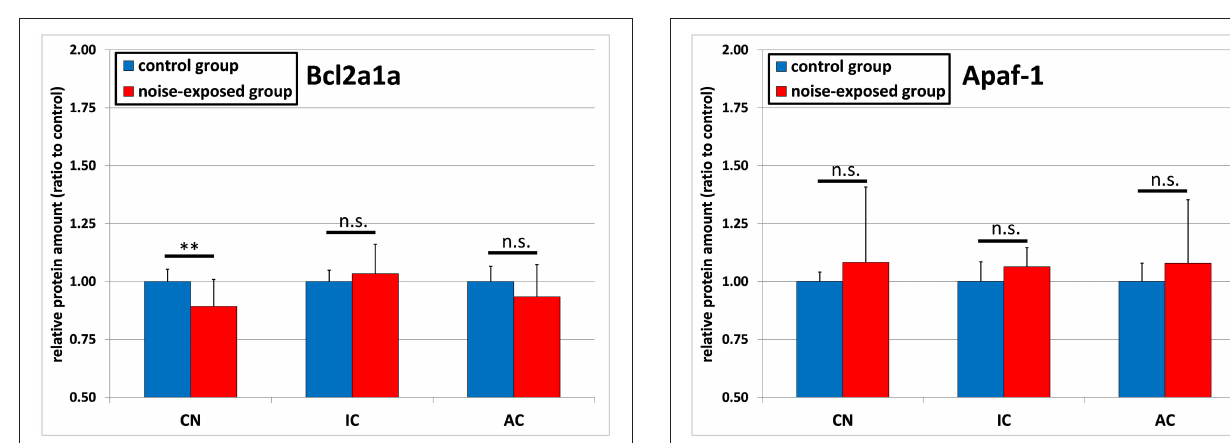
FIGURE 3 | Relative protein amounts of BCL2A1A. Presented are ratios to respective controls from the Western blot experiments (mean ± S.D.) in the cochlear nucleus (CN), inferior colliculus (IC) and auditory cortex (AC) of the mouse central auditory pathway immediately after noise trauma compared to unexposed controls. Asterisks indicate significant differences between control and trauma group (** p < 0.01; n.s., no significant difference between groups).